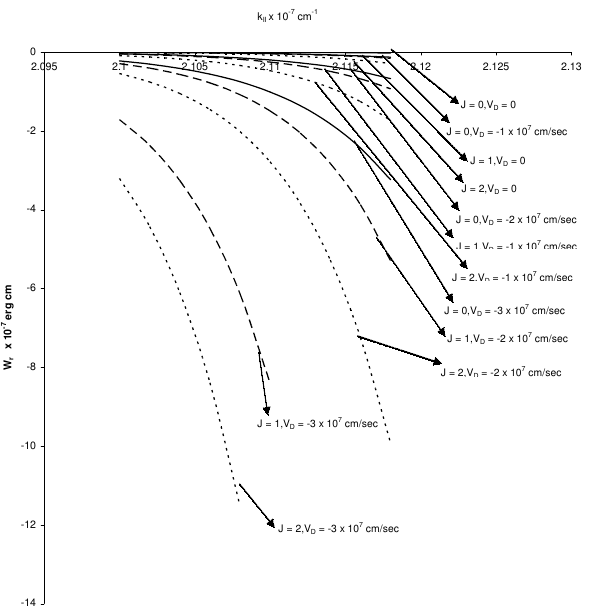
Fig. 2. Variation of perpendicular resonant energy W r ⊥ erg cm ver- sus wave vector k II cm − 1 for different values of ion beam V D , and Fig.2 Variation of perpendicular resonant energy W r ^ erg cm versus wave distribution index J =0, 1, 2, A =15. vector k II cm -1 for different values of ion beam velocity V D, and distribution index J=0,1,2, A=15